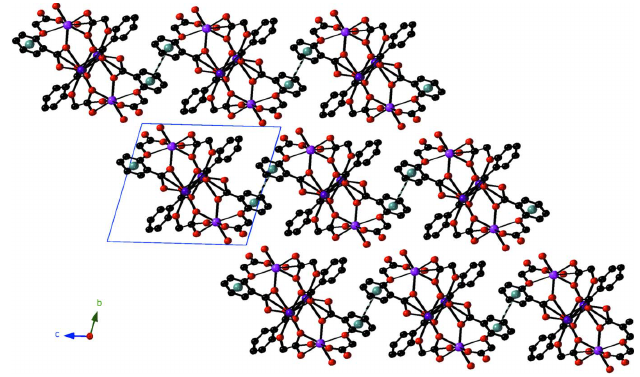
Figure 7 AAA pattern stacking of supramolecular layer motifs along the c -axis direction in the title compound, mediated by interlayer (cid:2) – (cid:2) stacking interactions, which are shown as dashed lines. Ring centroids of the cmb ligands are shown as teal